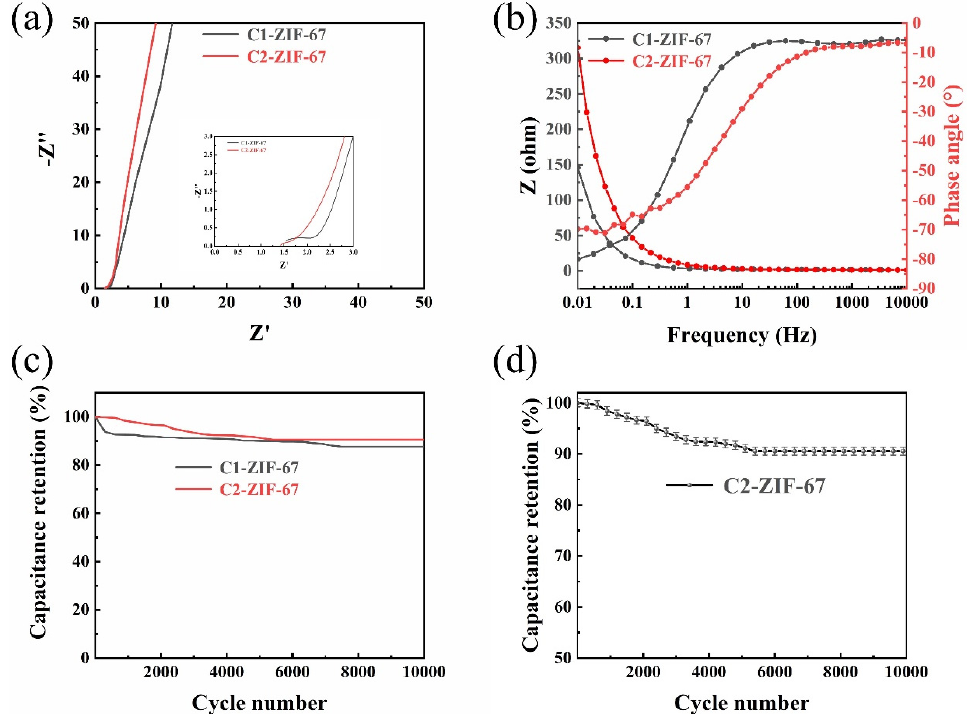
Figure 8. ( a ) AC impedance curve, ( b ) Bode phase angle and electrochemical impedance plots, ( c ) capacitance retention rate after 10,000 cycles for C1-ZIF-67 and C2-ZIF-67 and ( d ) capacitance retention rate after 10,000 cycles for C2-ZIF-67.